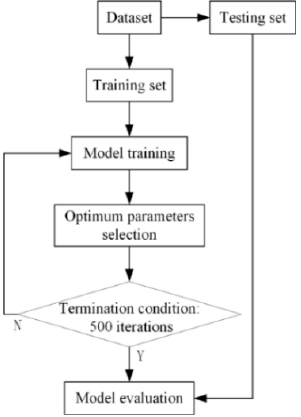
Figure 3. Process of LSTM prediction.